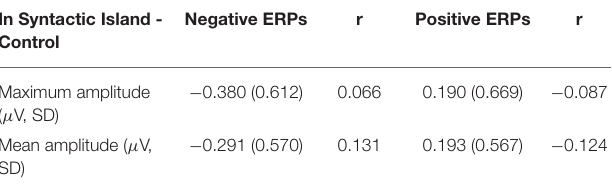
TABLE 7 | Effect size of the ERP for a syntactic island violation in In Syntactic Island of Head-noun First and its correlation coefficients with JRST scores. In Syntactic Island -